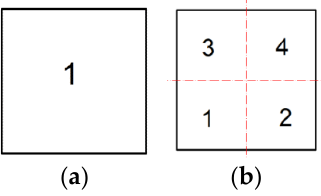
Figure 4. The adopted neighborhoods in the plate for swarm particles: ( a ) One neighborhood on the entire surface of the plate; ( b ) Four neighborhoods for the individual quarters of the plate.